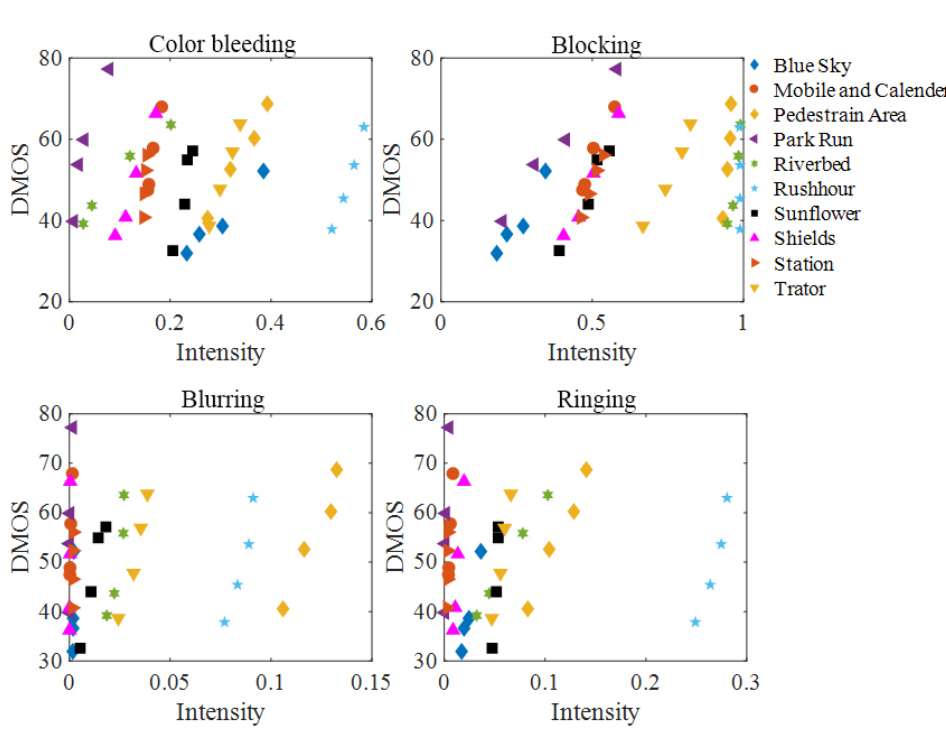
Figure 6. The scatterplot of each PEA intensity and DMOS on the LIVE Video Quality Database.